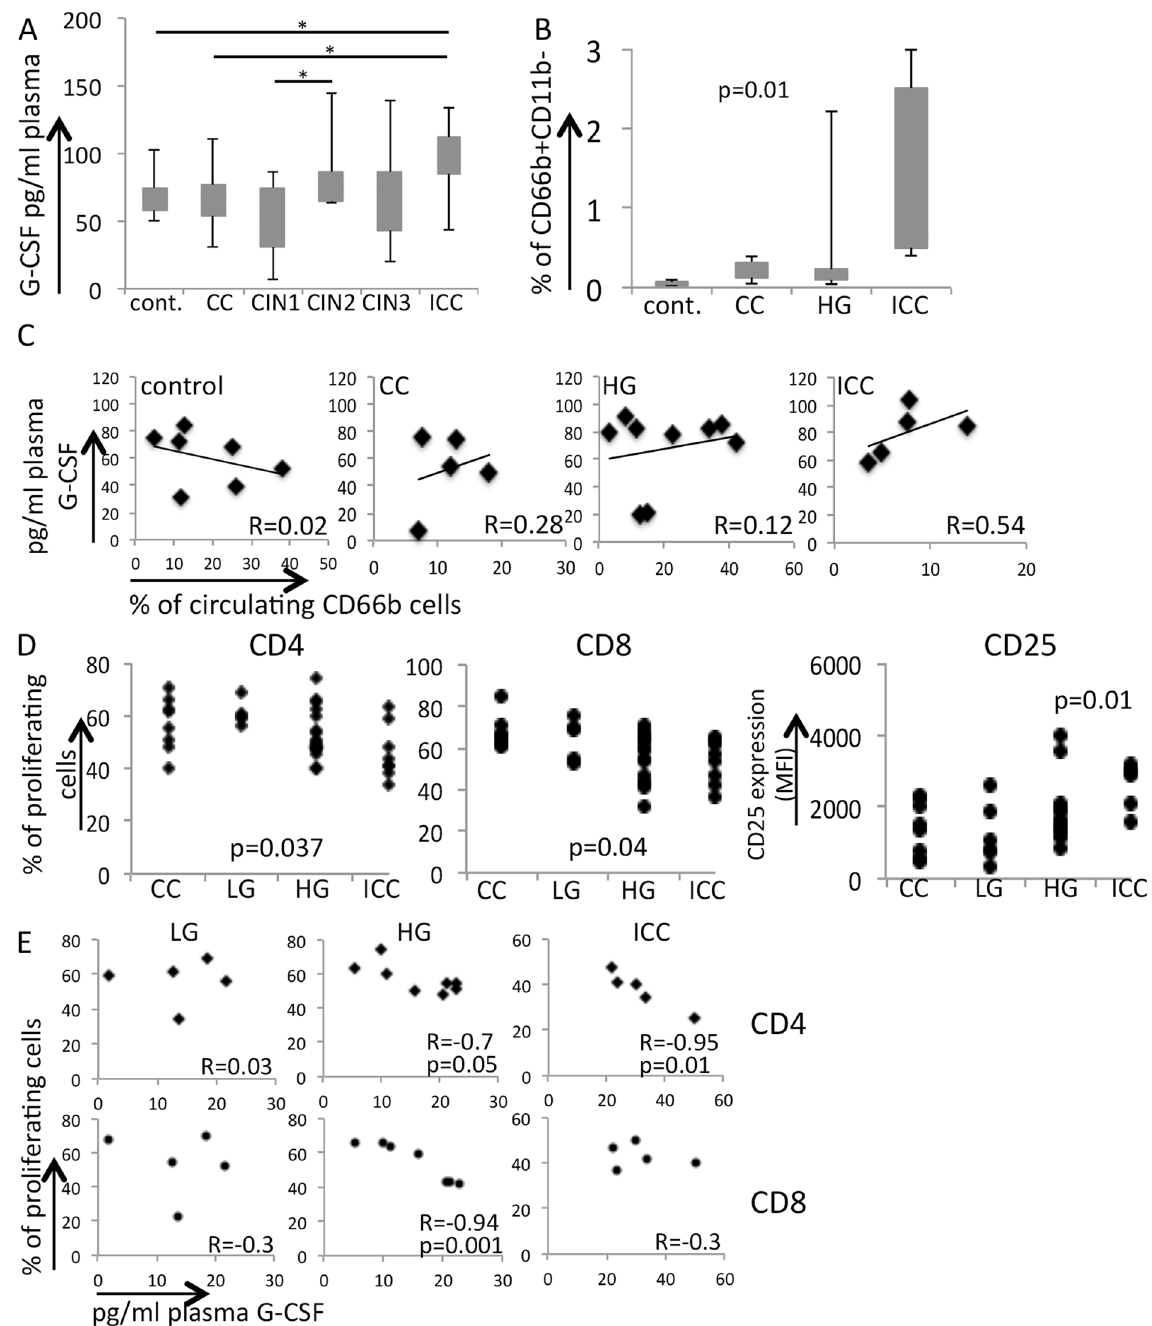
Figure 7. Cervical lesion systemic effects. ( A ) G-CSF plasma concentrations, measured by ELISA. We used plasma from 8 control donors, from 10 CC patients, 8 CIN1, 11 CIN2, 18 CIN3 and 17 ICC patients. Results were compared by one-way ANOVA, significant differences are indicated by * . ( B ) Frequency of immature circulating neutrophils. The mononuclear cells from the Ficoll-Paque gradient were harvested and labeled with anti-CD66b and CD11b. The graph shows the frequency of CD66b + CD11b − cells in each experimental group, which contained 5 controls, 4 CC patients, 13 high grade lesion patients (HG) and 11 ICC patients. We had only 2 patients with CIN1 lesions, therefore, had to exclude this group from this analysis. Again, results were tested with one-way ANOVA, and the p value is indicated. ( C ) Correlation between G-CSF plasma concentration and frequency of circulating immature neutrophils CD66b + . We used Pearson correlation to compare these parameters, R values indicated in each graph. ( D ) Allogeneic T cell stimulation. Cell proliferation dye labeled T cells from control donors were incubated for 4 days with MoDCs from patients of the indicated groups. After incubation, cells were harvested, labeled with CD4, CD8 and CD25 and analyzed by flow cytometry. Cell proliferation data shows the frequency of cells within the CD4 + or CD8 + T populations that diluted the proliferation dye, therefore, that proliferated during the experiments. CD25 expression, represented as median fluorescence intensity (MFI) was gated on CD4 T cells. We used one-way ANOVA to compare